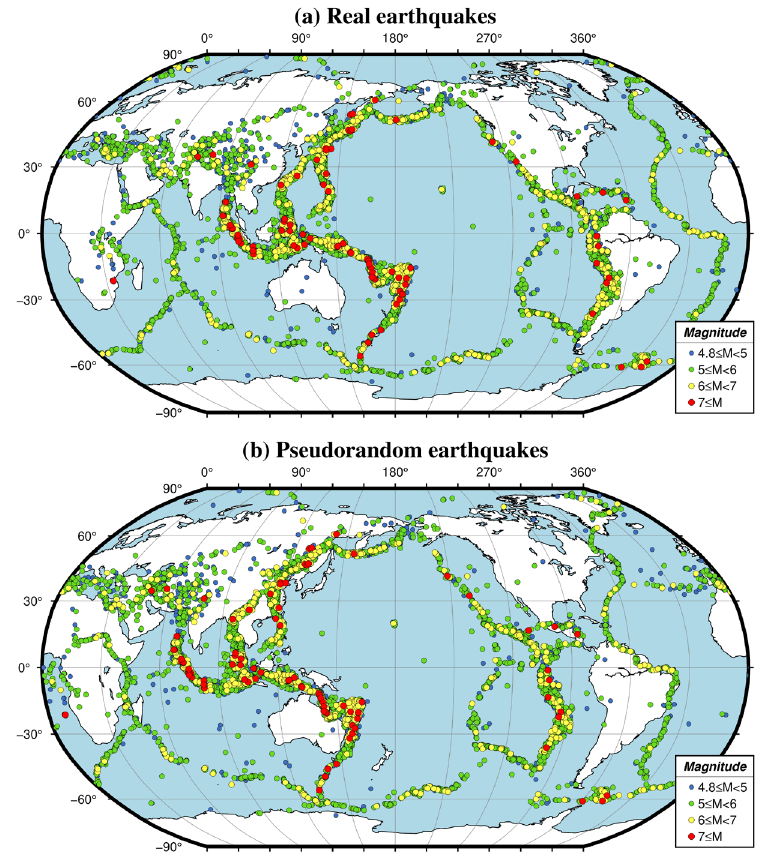
Figure 1. The global distribution of real earthquakes ( a ) and pseudorandom earthquakes ( b ).